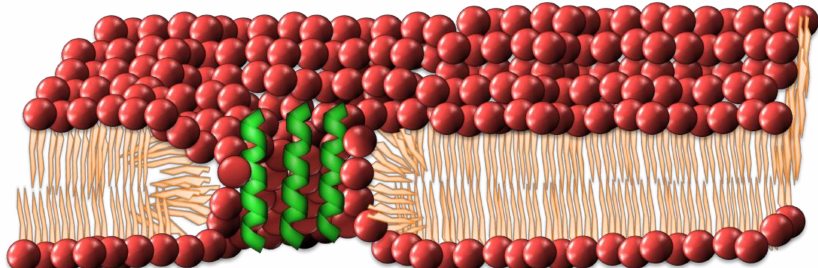
Figure 3. The toroidal pore model has the antimicrobial peptides (AMPs) interdigitated between lipid head groups as part of a pore within the membrane.